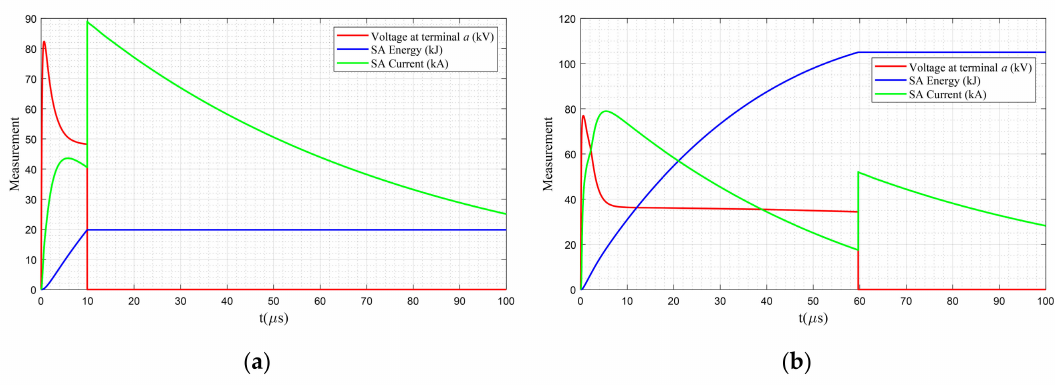
Figure 12. Failure of ( a ) SA-18a under 100 kV lightning impulse and ( b ) SA-18b under 125 kV lightning